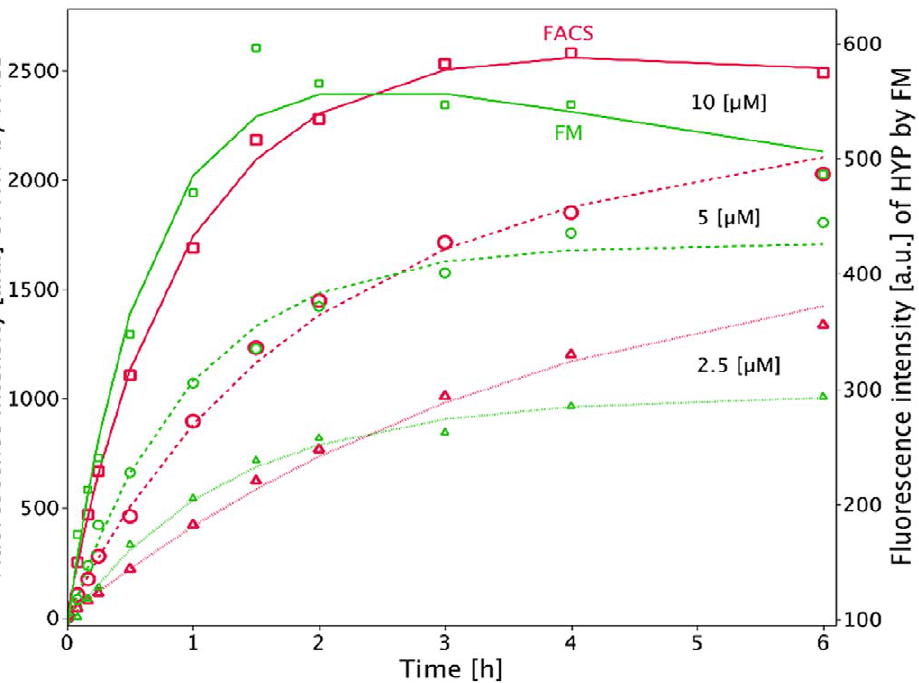
Figure 4. Comparison of FM (green) and FACS (red) of time-dependent HYP uptake in D283 Med cells incubated with 2.5 m M (dotted lines, triangles), 5 m M (dashed lines, open circles), and 10 m M (continuous lines, open squares) HYP. Curves were fitted according to Formula (2). The means for a , c , and A for 2.5, 5, and 10 m M, respectively, are: FACS: a : 0.168, 0.486, 1.08 [1/h]; c : 0.048, 0, 0.036 [1/h] and A : 3336, 2529, 2959 [a.u.], R 2 ~ 99 : 9% ; 99 : 9% ; 100% FM: a : 0.96, 1.05, 1.52 [1/h], c : 0, 0, 0.066 [1/h] and A : 295, 426.5, 639.5 [a.u.], R 2 ~ 99 : 7% ; 99 : 5% ; 99 : 1% . We calculated relative errors instead of absolute errors.